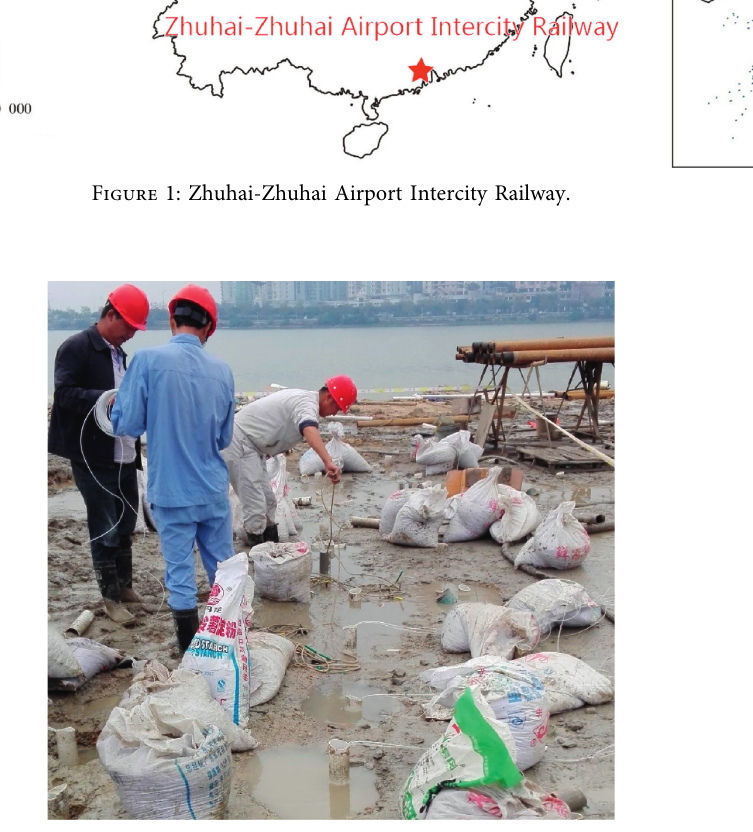
Figure 2: Diagram of charging on